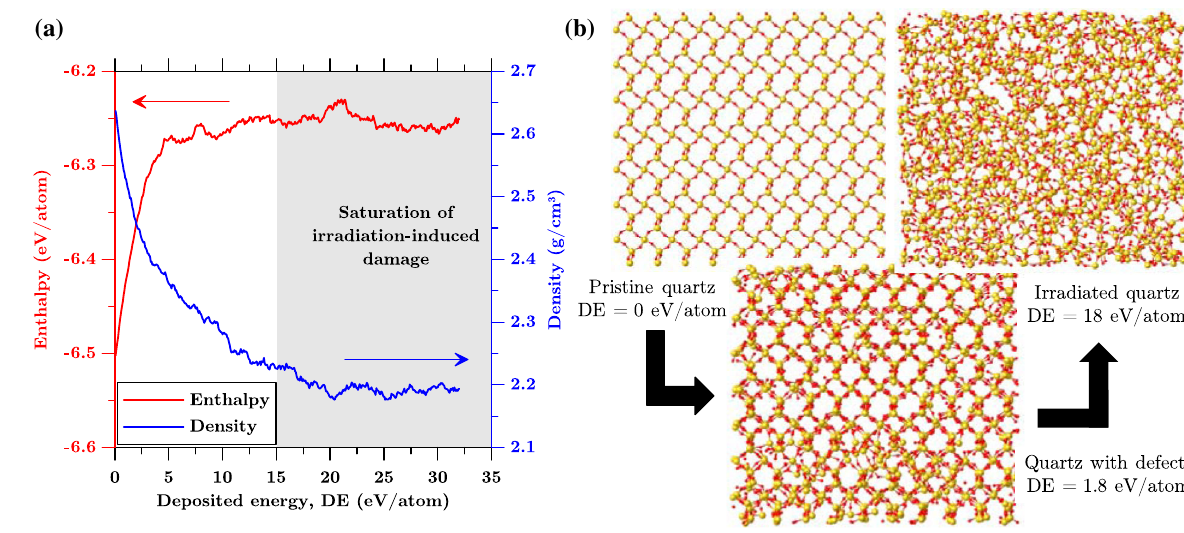
FIG. 1. Irradiation-induced disordering of quartz. (a) Enthalpy (left axis) and density (right axis) of irradiated α -quartz as a function of the deposited energy (DE). (b) Evolution of the structure of α -quartz following different amounts of (radiation) energy deposition, namely, 0 eV = atom, 1 . 8 eV = atom, and 18 eV =